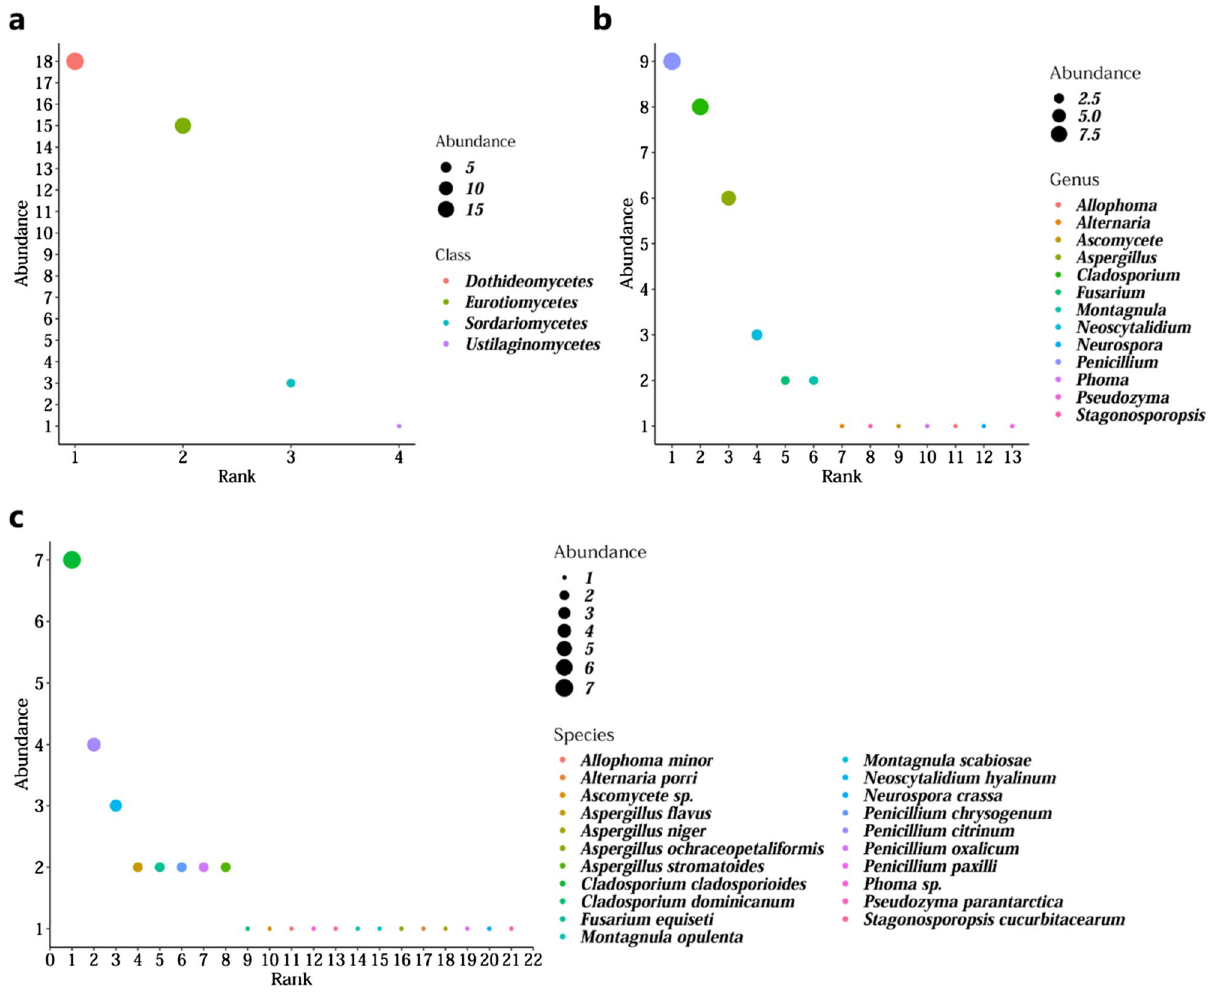
Figure 3. Ranked abundance for fungal ( a ) classes, ( b ) genera and ( c ) species. (RStudio software